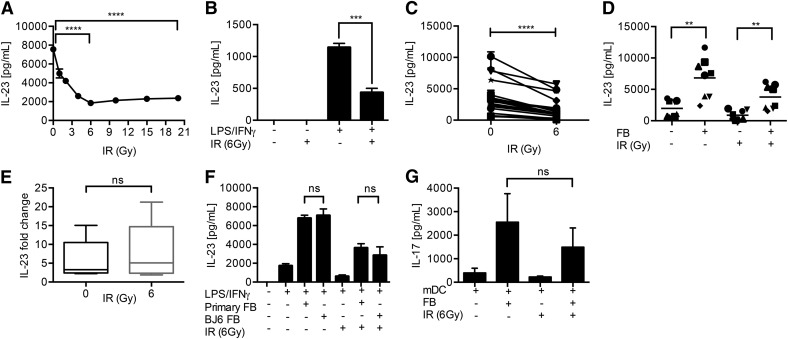
FBs promote the IL-23–Th17 axis during irradiation.IR suppresses IL-23. DCs were irradiated before addition of LPS/IFN-γ and IL-23 release measured by ELISA. (A) IL-23 suppression was dependent on the dose of IR (a representative donor from 3). (B) A representative experiment at 6 Gy. (C) A summary of 18 donors. (D) FBs rescue IL-23 secretion by irradiated DCs. Coculture of irradiated FBs with irradiated DCs up-regulated IL-23 secretion (summary of 8 donors). (E) Fold change of IL-23 secretion by irradiated DC/FB cocultures at 0 and 6 Gy. (F) Primary dermal FBs demonstrate similar IL-23-enhancing activity to the BJ6 cell line (data from a representative donor or 5). (G) FBs permit irradiated DCs to promote Th17 responses. IL-17A secretion by naïve CD4+ T cells activated with anti-CD3/anti-CD28 in the presence of supernatants of the indicated DC/FB cultures. T cells were stimulated for 5 d and IL-17A secretion determined after restimulation (collective data from 3 donors). Error bars indicate sd of triplicate experiments. **0.01 > P ≥ 0.001, ***0.001 > P ≥ 0.0001, ****P < 0.0001; ns, not significant. Results are presented as means ± sd.